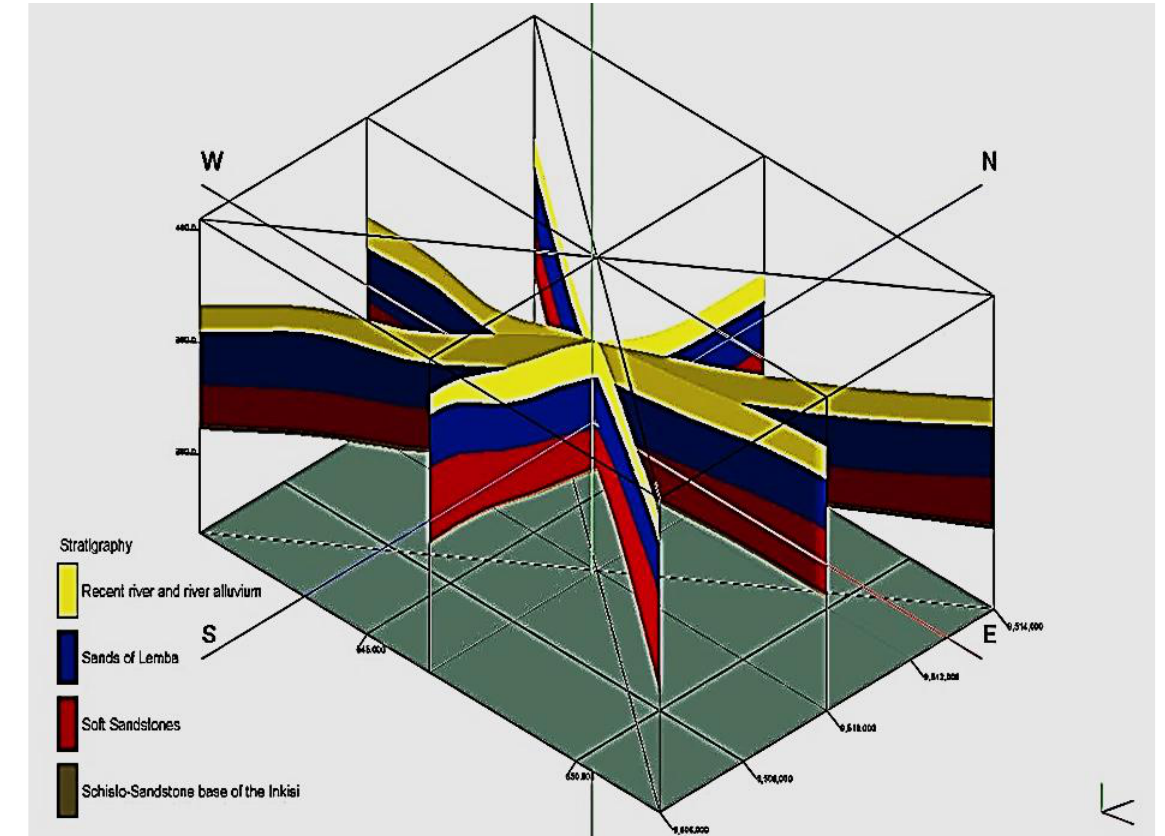
Figure 13. Stratigraphy fence diagram.